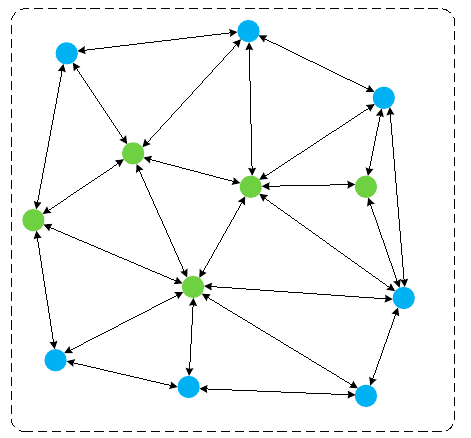
Figure 3. Overview of the decentralized controller.